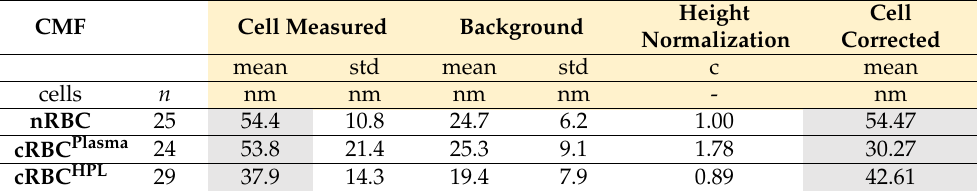
Table 3. Cell membrane fluctuation (CMF) determined by DHM. The height normalization coefficient, c, is calculated using the mean height, hm, given in Table 2. Corrected CMF is obtained from measured CMF divided by the normalization coefficient